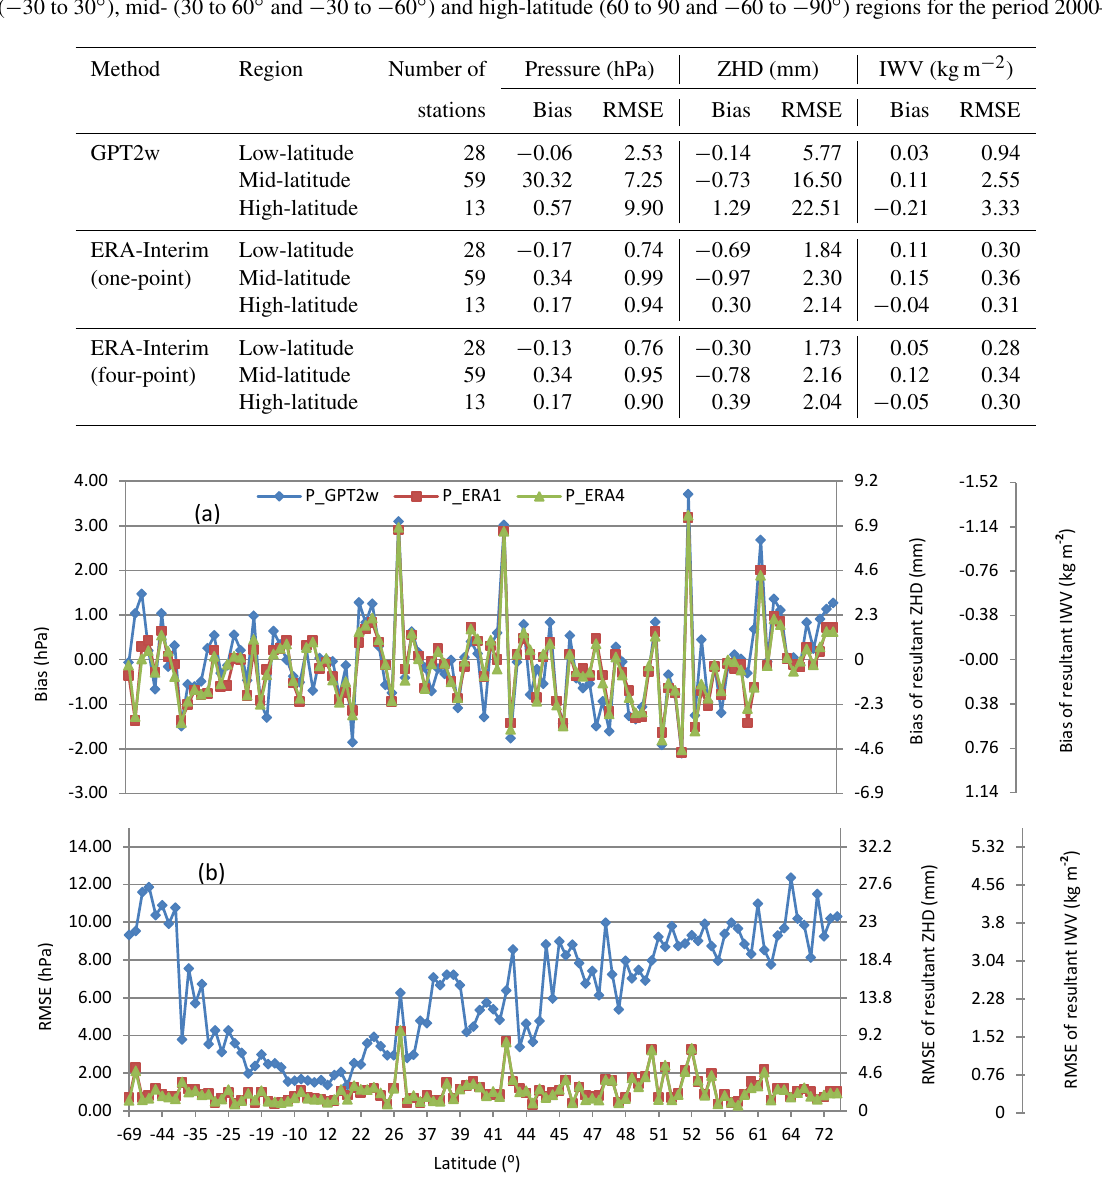
Figure 2. Distribution of biases (a) and RMSEs (b) of 6h P_GPT2w, P_ERA1 and P_ERA4 with latitudes across 108 GNSS stations for the period of 2000–2013. IWV is integrated water